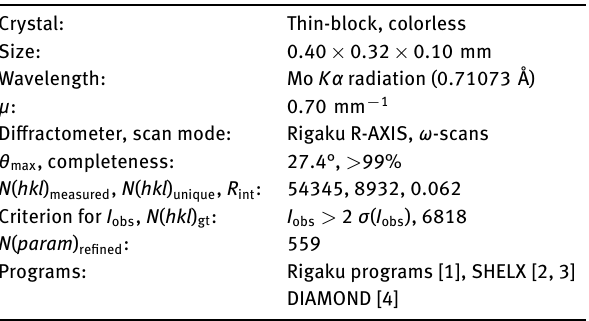
Table 1: Data collection and